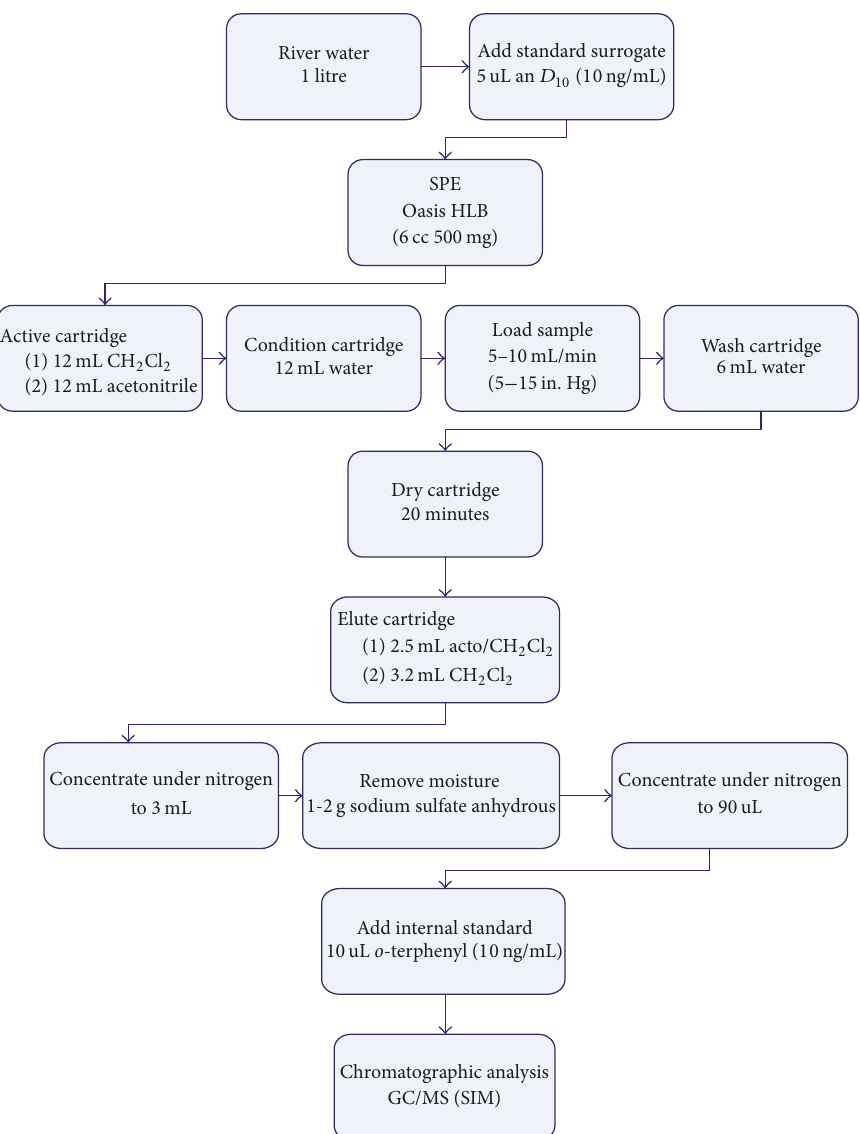
Figure 1: Scheme of the proposed analytical method to quantify the selected organochlorine pesticides in water.